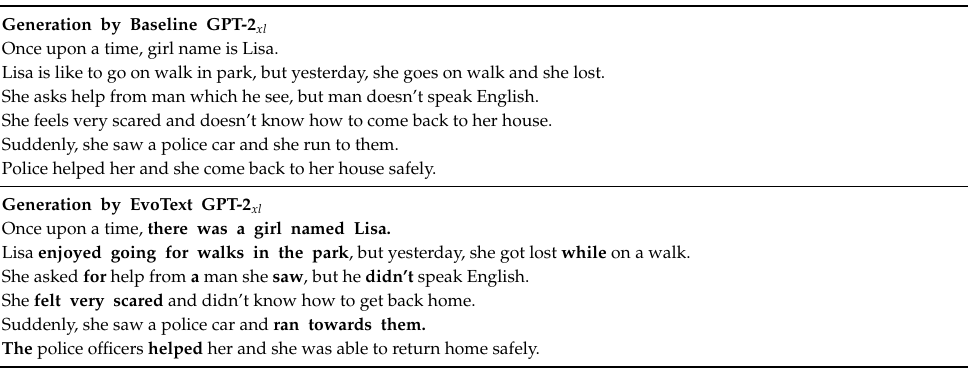
Table 8. We entered “Once upon a time” into Baseline’s GPT-2 xl and EvoText GPT-2 xl , respectively, for